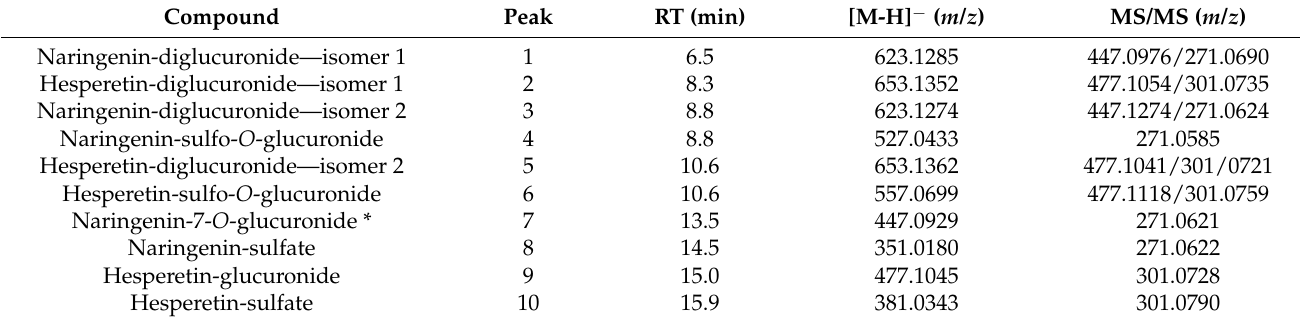
Table 2. Mass spectra data of phase II metabolites of flavanones detected in urine by LC-qTOF-MS/MS after single doses of pasteurized Pera and Moro orange